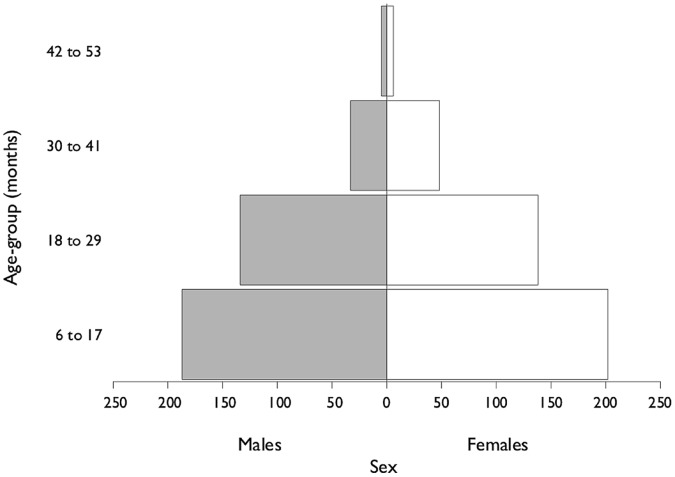
Population profile of the Outpatient Therapeutic Program.